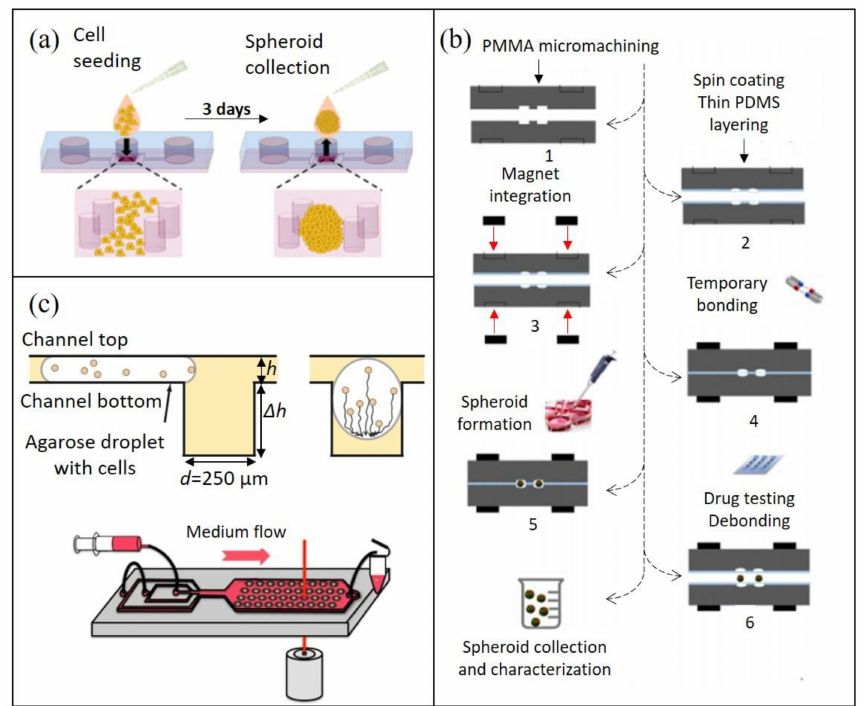
Figure 3. Tumor spheroid recovery for off-chip analysis: ( a ) the process of cell seeding and spheroid harvesting by pipetting from a microfluidic pillar array device (adapted from [78]); ( b ) schematic of the fabrication of a reversibly sealed microfluidic device and its subsequent use for tumor microtissue cultivation, drug testing and recovery (adapted from [81]); ( c ) schematic of spheroid formation within an agarose droplet after trapping and sedimentation into an anchor on the microfluidic chip (top), as well as controlled agarose embedded spheroid recovery from a microfluidic device by selective heating with an infrared laser beam (bottom) (adapted from